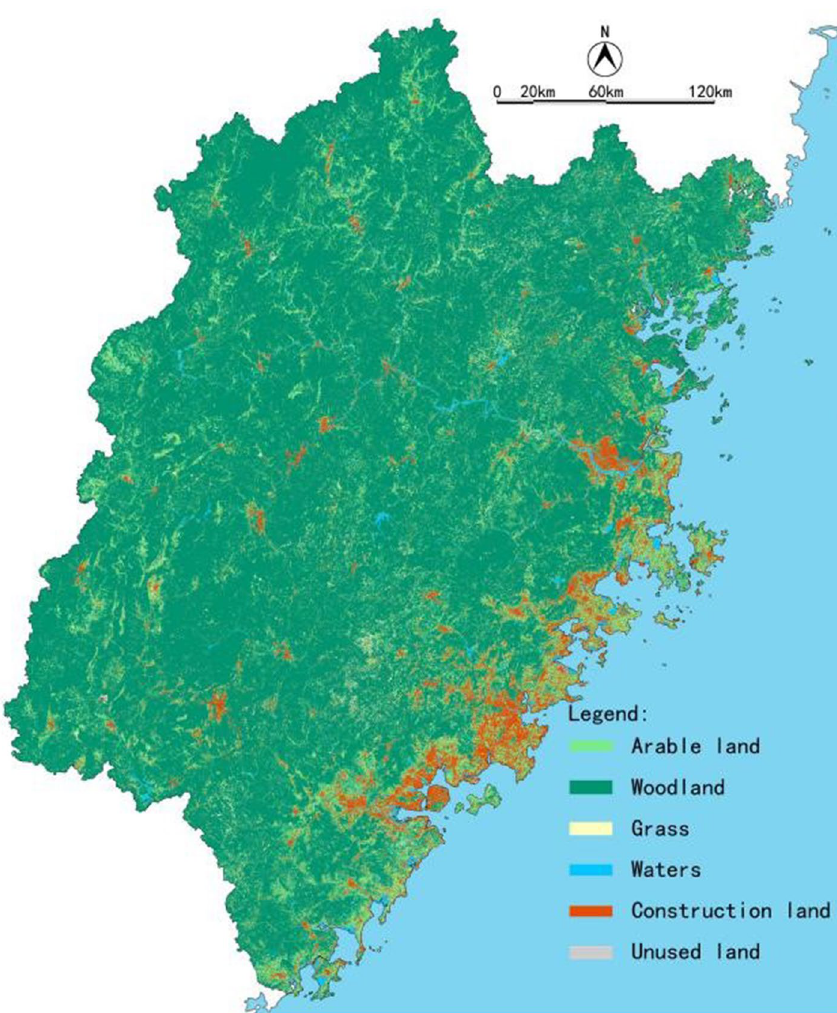
Figure 3. Land use status map for Fujian